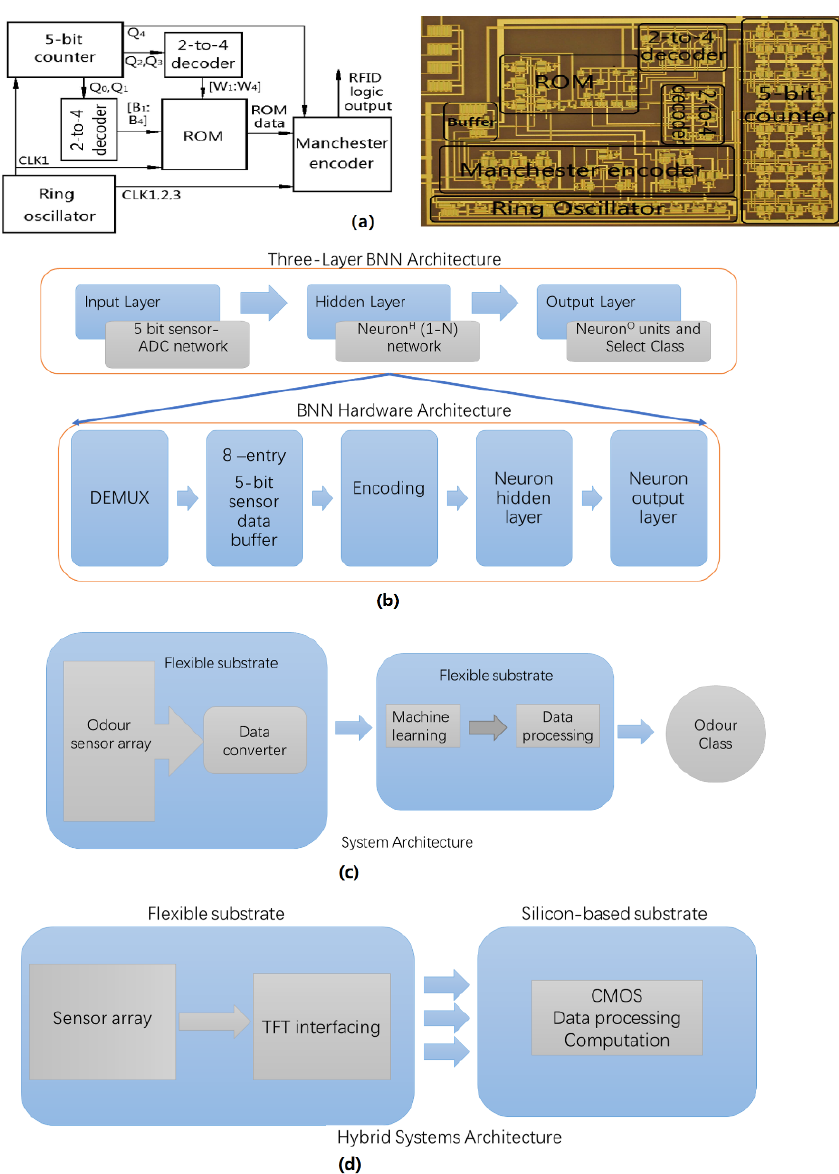
Figure 18. ( a ) Schematic diagram and optical image of RFID circuit [163] (Reprinted with permis- sion from ref. [163]. Copyright 2022 INSTITUTION OF ENGINEERING AND TECHNOLOGY), ( b ) Diagram of BNN and hardware architectures, ( c ) Diagram of the system architecture of the natively flexible processing engine, and ( d ) Diagram of the system architecture and conceptual implementation of large-area sensor acquisition hybrid